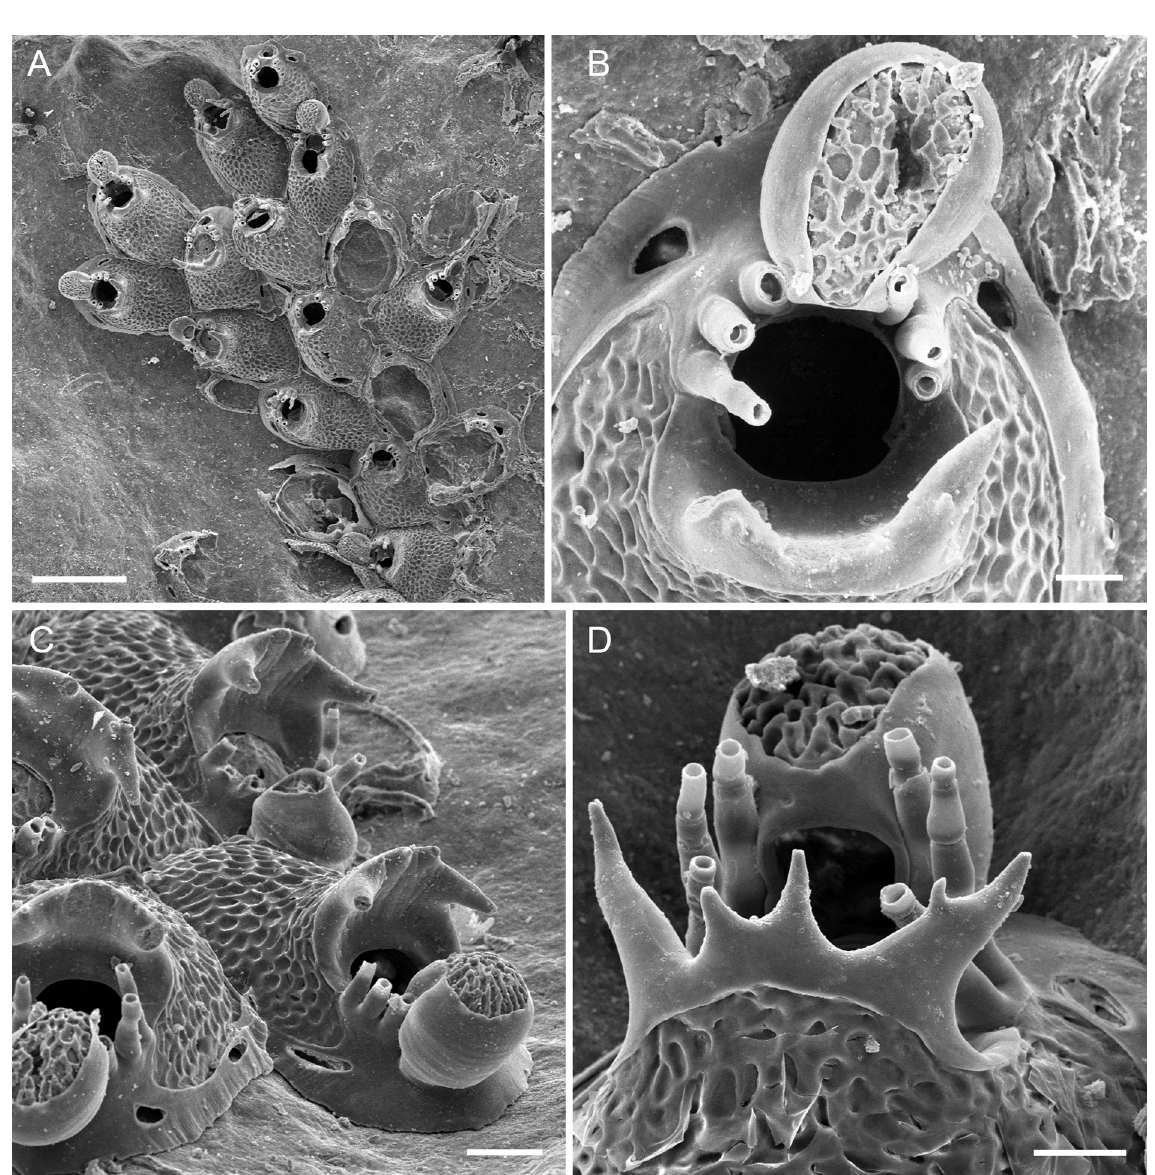
Fig. 7. Atlantisina lionensis gen. et sp. nov., Lion Smt, paratype (MNHN-IB-2014-67). A . Colony overview. B . Orifice and slightly damaged ooecium. C . Ovicellate zooids at the colony growth margin. D . Close-up of the suboral crest. Scale bars: A = 500 µm; B, D = 50 µm; C = 100